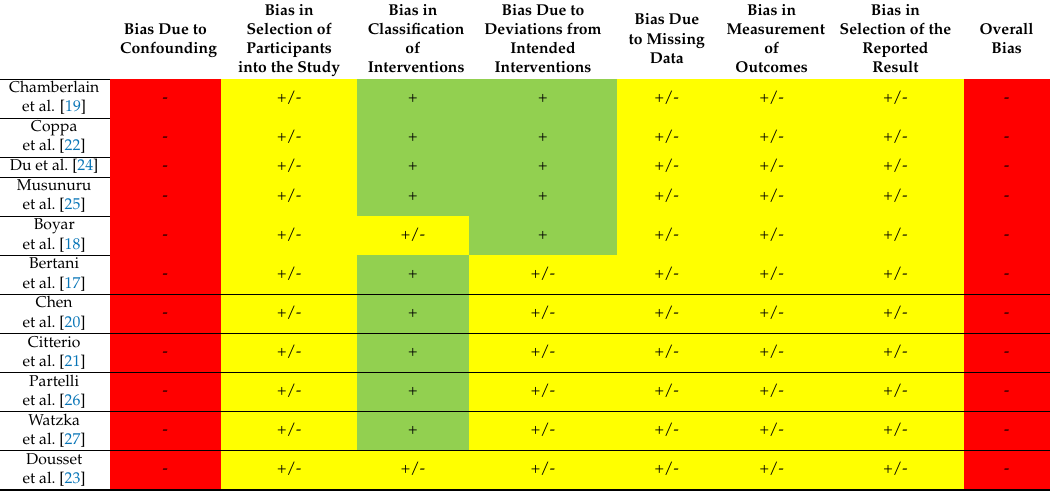
Table 3. Risk of bias in included studies scored with the ROBINS-I tool.